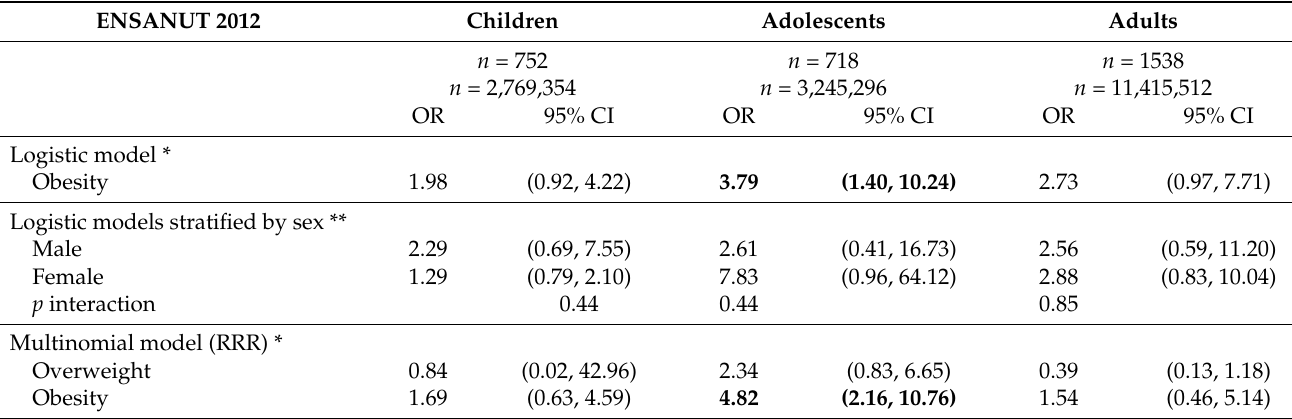
Table 3. Association between past year PM 2.5 (10 µ g/m 3 increase) with obesity in children, adolescents, and adults from the Greater Mexico City Area using data from the 2012 National Nutrition and Health Survey, ENSANUT-2012.